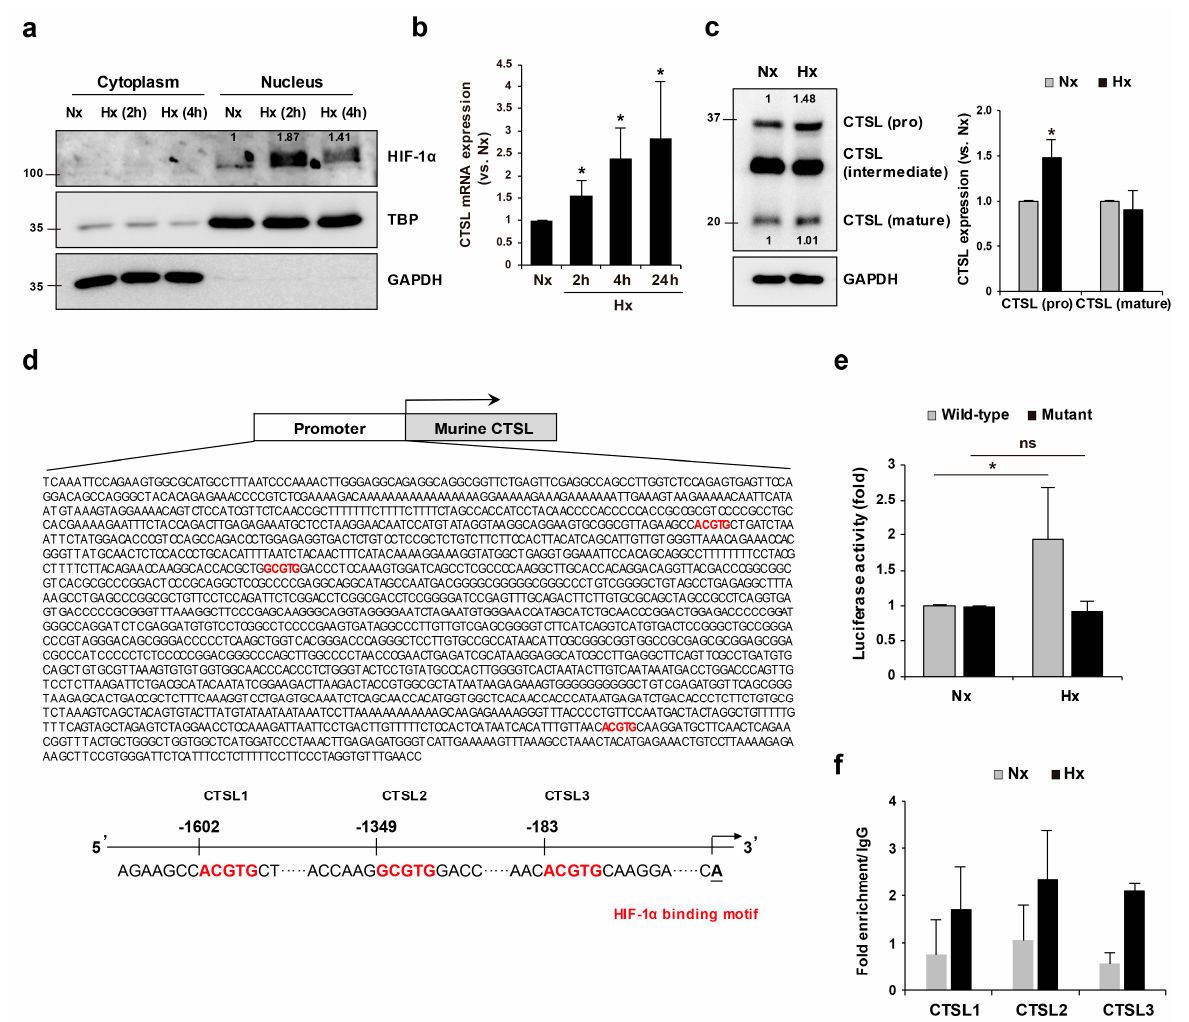
Figure 1. Hypoxic condition enhanced HIF-1 α and CTSL activation. ( a ) Western blotting analysis of cytosolic and nuclear fractions of HIF-1 α under normoxic or hypoxic conditions. mRNA ( b ) and protein ( c ) levels of CTSL were assessed in melan-a cells in hypoxia. ( d ) HREs in CTSL promoter were predicted. ( e ) Cells were transfected with luciferase reporter vectors, pGL3-Ctsl/HRE or pGL3-Ctsl/mutHRE, and luciferase activity was determined under hypoxic conditions for 4 h. ( f ) ChIP-qPCR analysis for HIF1- α occupancy on CTSL promoter in melan-a cells in normoxa or hypoxia for 4 h. Quantification of enrichment was represented as fold-enrichment relative to IgG. Results are expressed as mean ± S.D of more than three independent experiments. * p < 0.05. Student’s t- test.